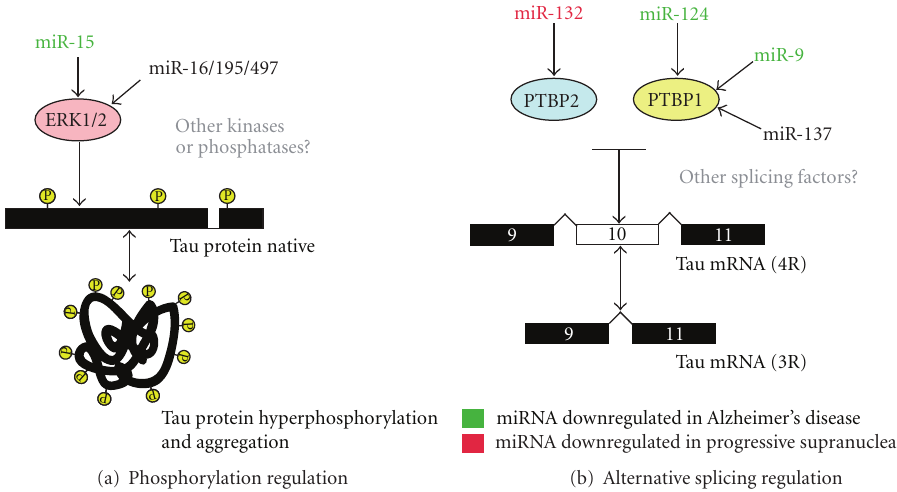
Figure 1: Potential role of miRNAs in tau metabolism regulation. (a, b) Two models are shown demonstrating how specific miRNAs could be involved in the regulation of tau phosphorylation (and aggregation) and/or tau exon 10 alternative splicing. Note that some miRNAs are a ff ected in disease conditions (in green, downregulated in AD; in red, downregulated in PSP). Whether other miRNA target e ff ectors are involved in the physiological and/or pathological regulation of tau metabolism remains to be explored. Any changes in the level or function of these miRNAs could have serious biological consequences, including tau hyperphosphorylation and aggregation and an imbalance in tau microtubule-binding repeats (encoded in tau exon 10, giving rise to either four 4R-tau or 3R-tau). Regulation of tau exon 10 splicing by PTBP1 or PTBP2 may be direct or may implicate other coregulators such as TDP-43 or PSF, both of which have been shown to either regulate PTBP2 expression or regulate PTBP splicing and repress tau exon 10 inclusion [26,